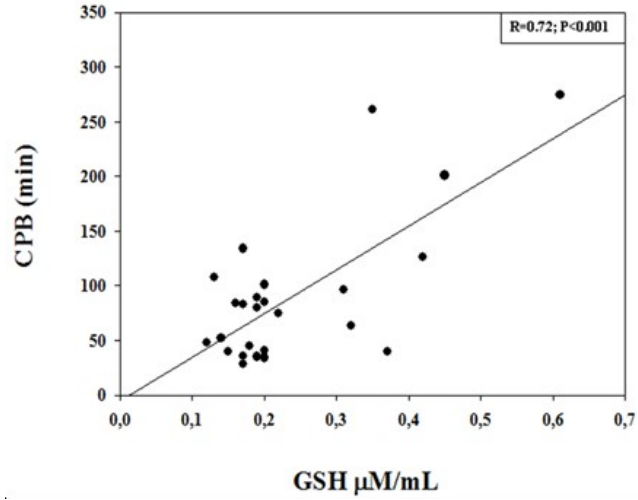
Figure 2. Correlation between GSH concentrations (μM/mL) measured at the end of cardiopulmonary bypass (CPB) procedure and CPB duration (min). There was a significant positive correlation ( R = 0.72; p < 0.001).